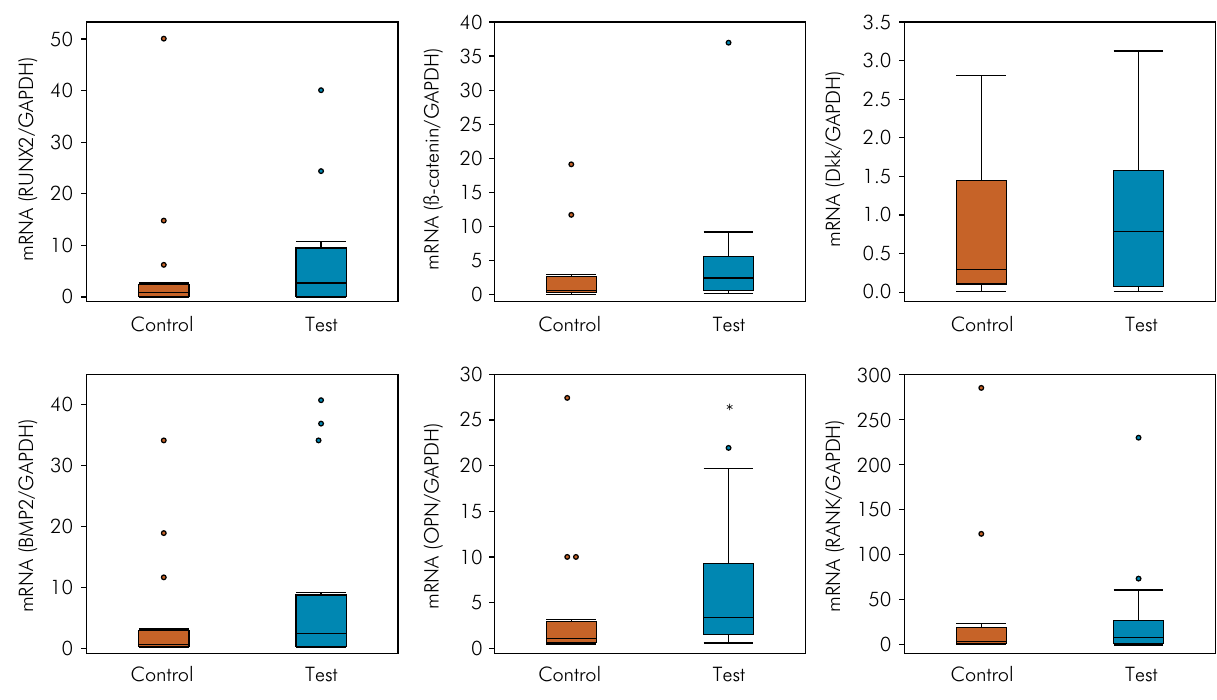
Figure 3. Gene expression